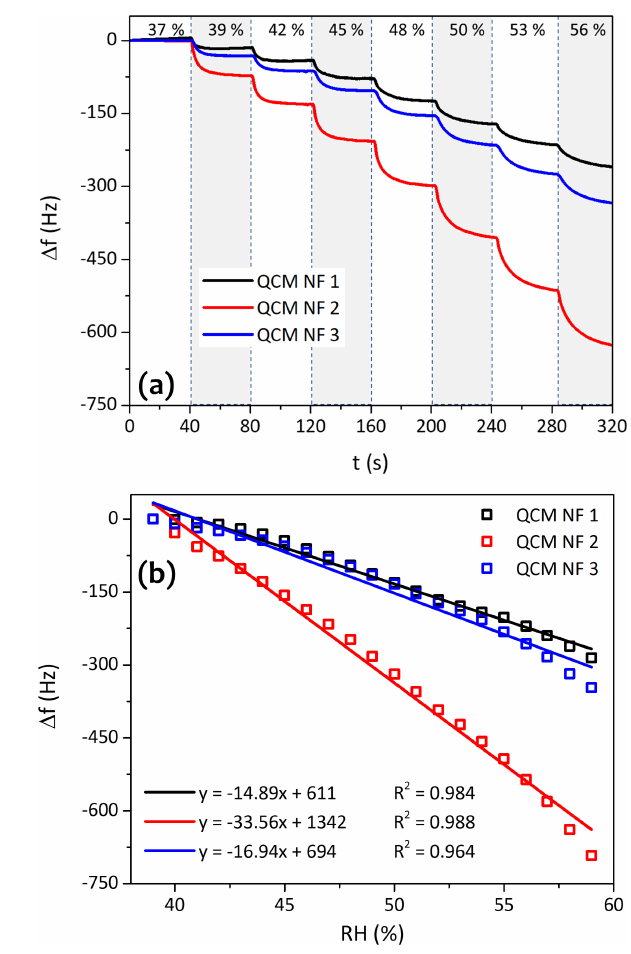
Figure 4. (a) The PEDOT–PSS/PVA QCM response to the increas- ing humidity level and (b) (cid:49)f value of the QCM sensor exposed to different humidity